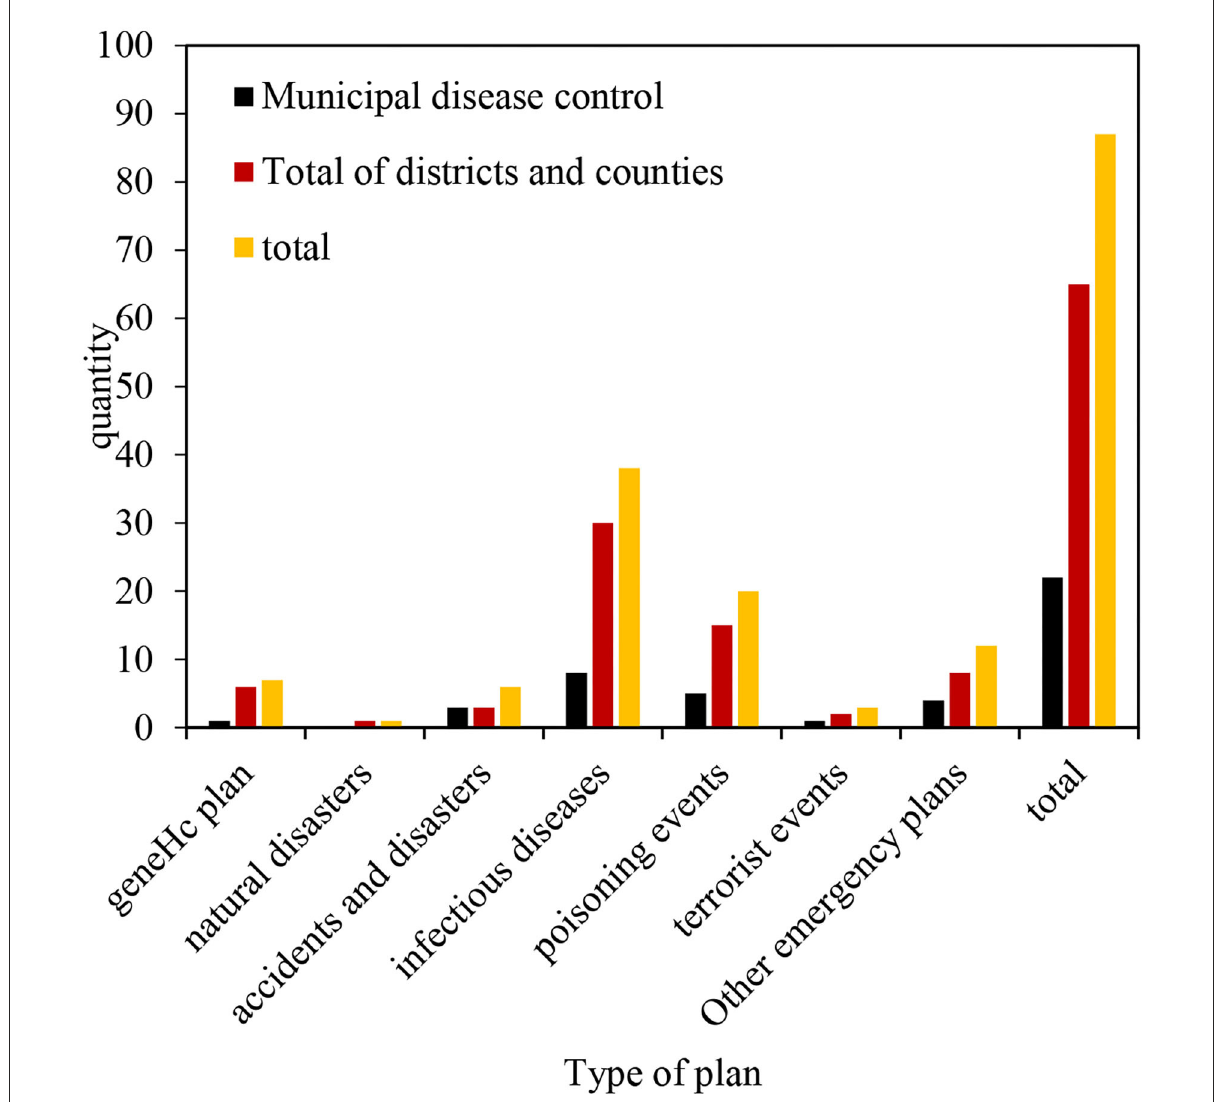
FIGURE3 Plan formulation of disease prevention and control institutions in M